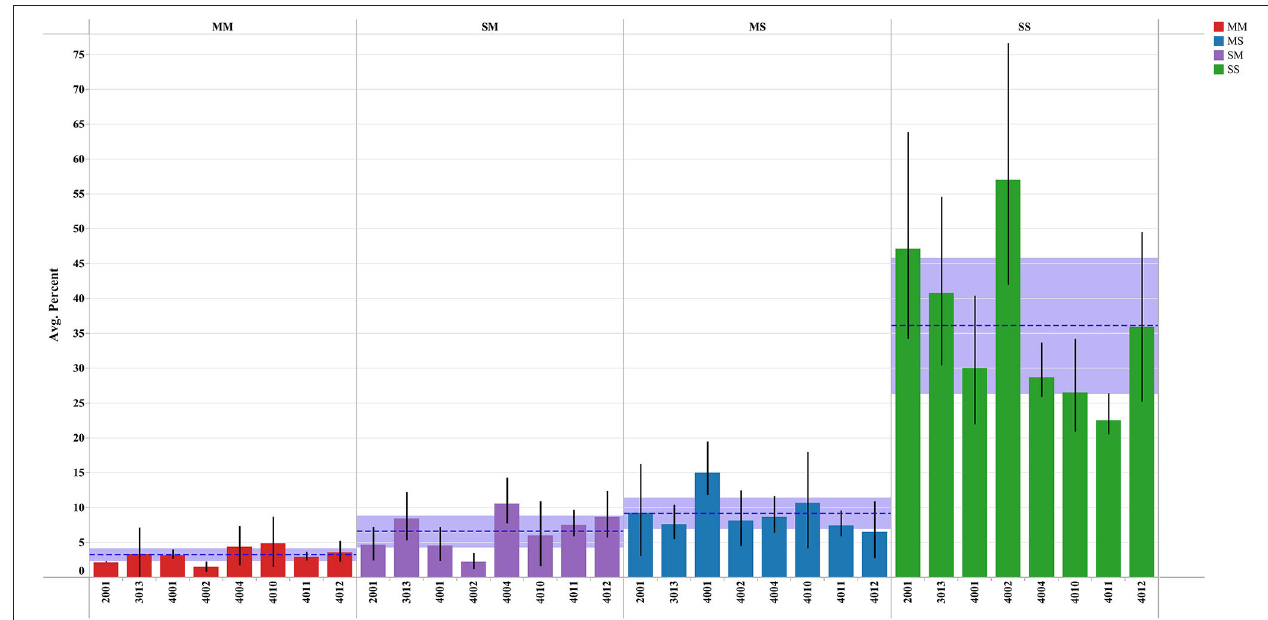
FIGURE 1 | Percent of time children and parents spend together (within 50m) in moderate to vigorous physical activity and sedentary time. MM, both engaged in MVPA; SM, child is sedentary and parent in MVPA; MS, child in MVPA and parent is sedentary; SS, both child and parent are sedentary. Results are limited to data with following restrictions: nine or more measurement pair hours per day; participants with more than four valid days of accelerometer wear time; and participants (parent-child pairs) within a 50m range of each other.